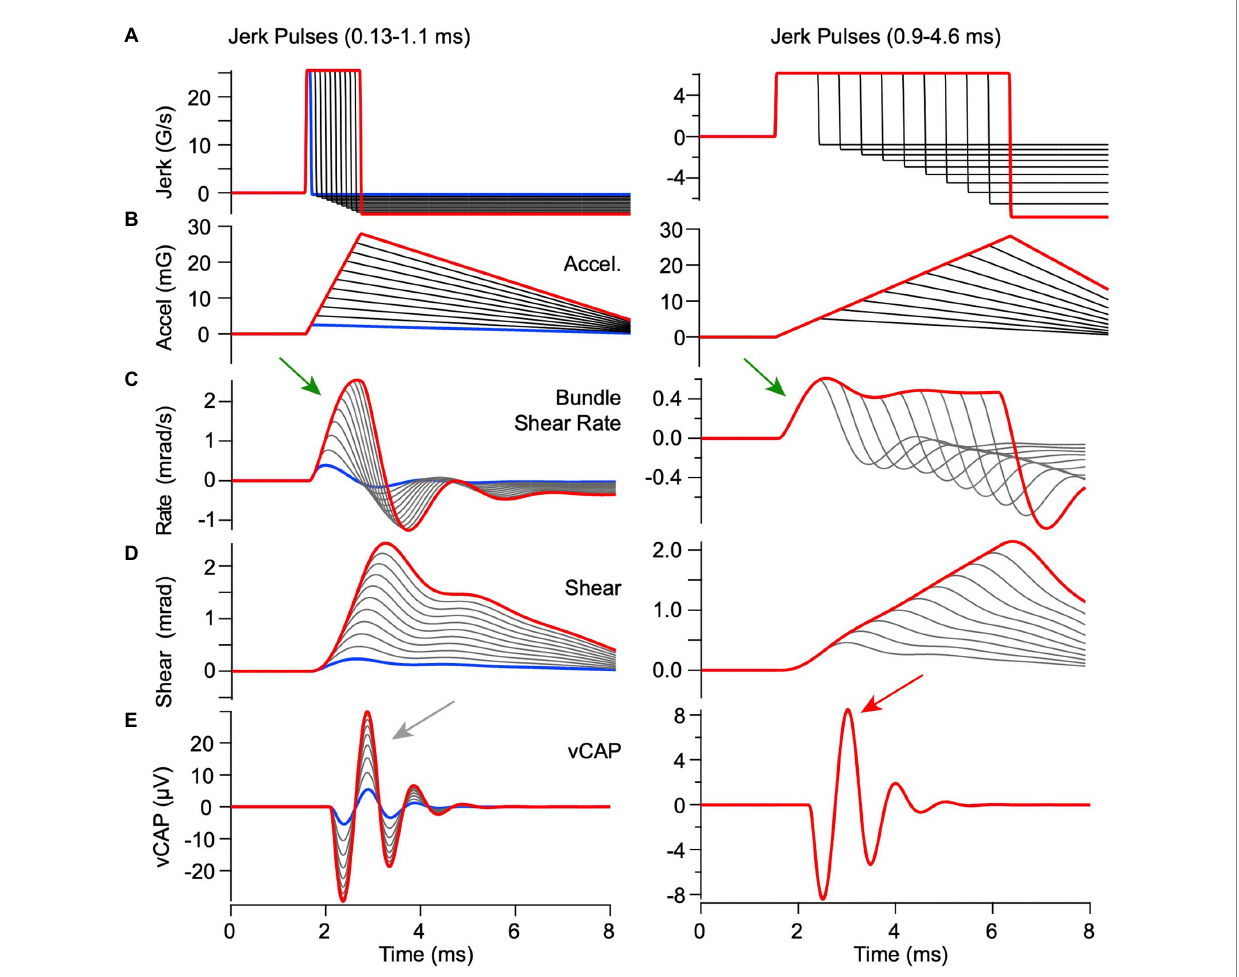
FIGURE 8 Predicted responses to BCV stimuli with constant peak linear jerk but variable acceleration. Model parameters are the same as previous figures. (A) linear jerk, (B) linear acceleration, (C) hair bundle shear rate, (D) hair bundle shear, and (E) vCAP. Constant jerk stimuli with short durations <0.8 ms [ (A) left] evoked hair bundle shear [ (D) left] and shear rate [ (C) left] that increased in proportion to peak acceleration [ (B) left] thus leading to vCAPs that increased magnitude with pulse width [ (E) left, curves scale with acceleration, arrow]. In contrast, constant jerk stimuli with long durations >0.9 ms [ (A) right] all evoked the same bundle shear rate within the first 1 ms of the stimulus [ (C) right, arrow] irrespective of the peak acceleration, thus triggering equivalent vCAPs [ (E) right, all curves superimposed, arrow]. Results demonstrate a switch from acceleration as the adequate stimulus for short pulses to jerk as the adequate stimulus for long